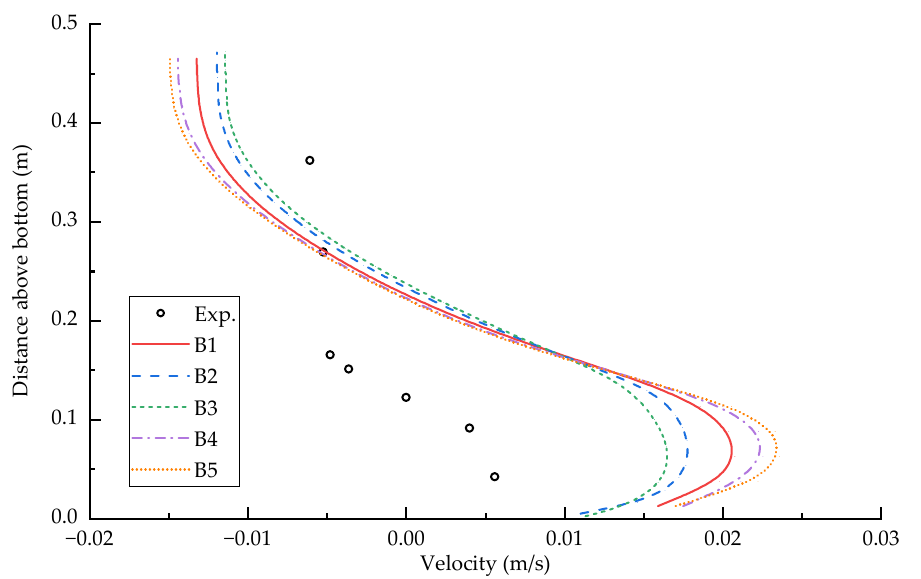
Figure 7. Velocity profile at position 11.43 m from upstream at 11 min of the z-coordinate system model with different grid resolutions.